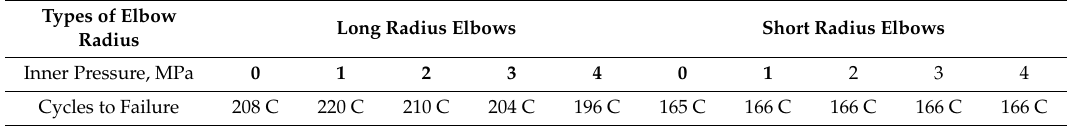
Table 3. Total fatigue life (number of cycles to failure) and location of failure for sound